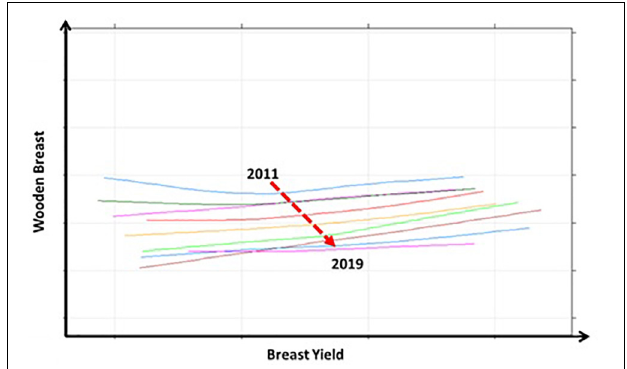
FIGURE 6 | The long term relationship between breast yield (%) and wooden breast (%) for the years 2011 to 2019 is displayed in this graph. The different coloured lines each represent the year long relationship between breeding values for each trait for each year. The broken arrow shows the movement of the mean breeding value for each trait from 2011 to 2019. It shows that there has been a yearly decrease in the mean breeding value for wooden breast whilst the mean breeding value for breast yield has